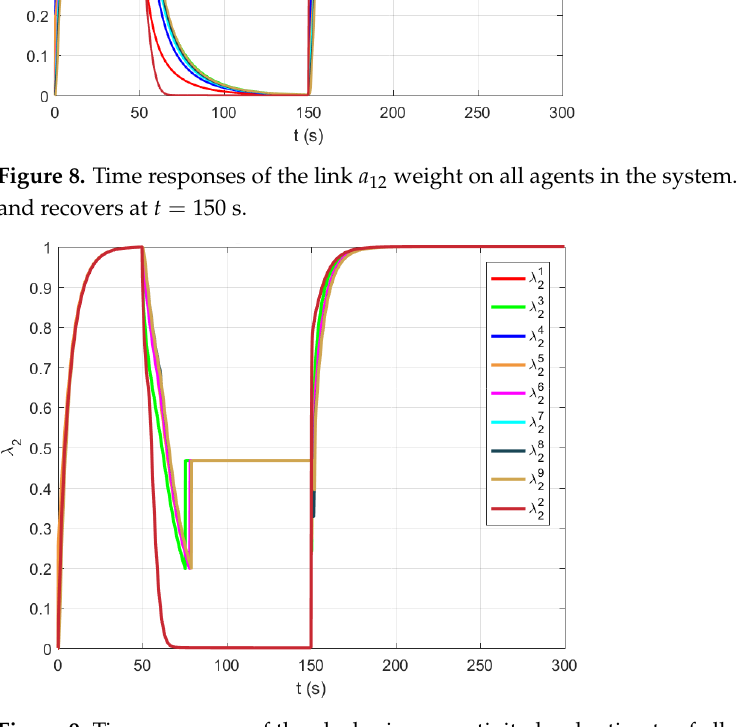
Figure 9. Time responses of the algebraic connectivity local estimate of all agents in the